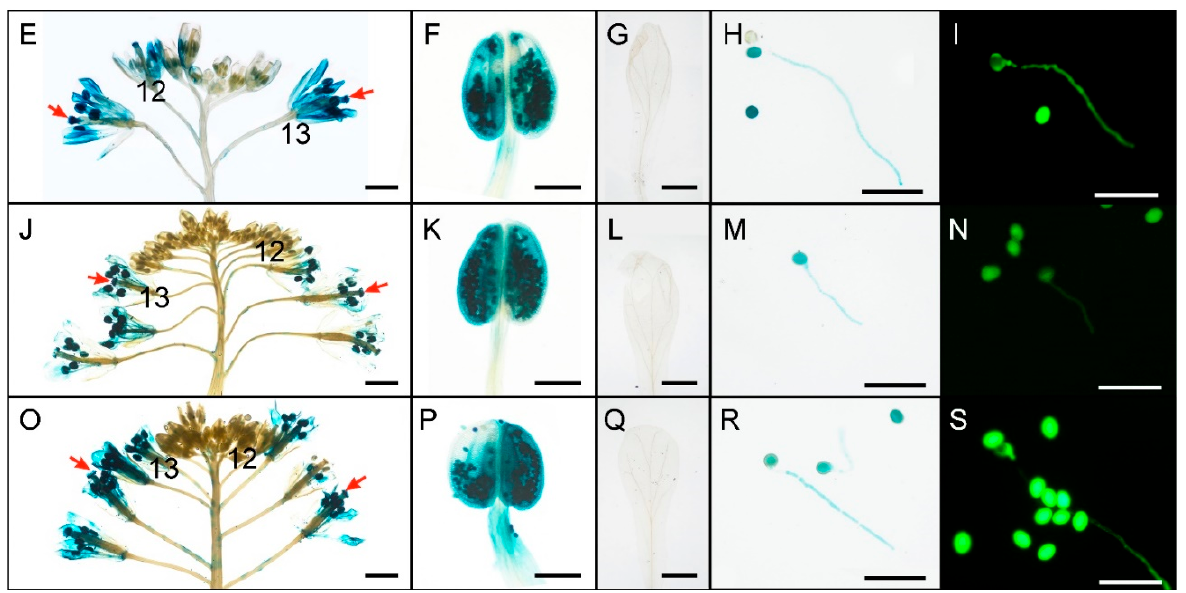
Figure 5. Expression analysis of BrFLA2 , BrFLA28 and BrFLA32 in genic male-sterile system ‘ Bcajh97-01A/B ’ of Brassica rapa . ( A – D ) Quantitative real-time PCR analysis of BrFLA2 , BrFLA28 and BrFLA32 . The values are the mean ± standard deviation (SD). Different letters indicate statistical significance ( p < 0.01) as determined by a one-way ANOVA test. R, root; Ste, stem; L, young leaf; Inf, inflorescence; Si, germinal silique; A, homozygous male-sterile line ‘ Bcajh97-01A ’; B, heterozygous male-fertile line ‘ Bcajh97-01B ’; S1–S5, pollen mother cell stage, tetrad stage, uninucleate stage, binucleate stage and mature pollen stage; Se, sepal; Pe, petal; sta, stamen; Gy, gynoecium; 1, 3 and 10 h, the corresponding time after pollination; CK, the corresponding un-pollinated pistils. ( E – H , J – M , O – R ) GUS staining in P BrFLA2 :: GUS ( E – H ), P BrFLA28 :: GUS ( J – M ) and P BrFLA32 :: GUS ( O – R ) transgenic plants. ( E , J , O ) Stained inflorescences. ( F , K , P ) Magnified images of an anther as shown in ( E , J , O ). ( G , L , Q ) Stained petals. ( H , M , R ) Stained pollen grains and pollen tubes germinated in vitro. ( I , N , S ) GFP